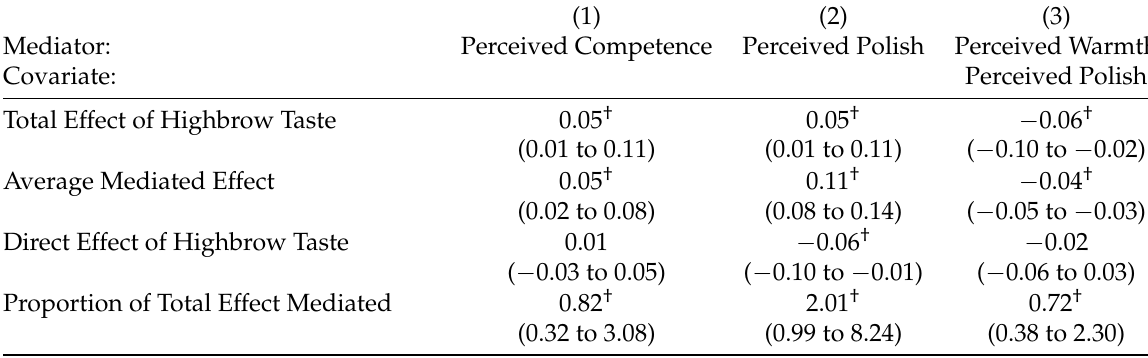
Table 6: Average marginal effect of signals of highbrow taste on likelihood of interview mediated by percep- tions of competence, polish, and